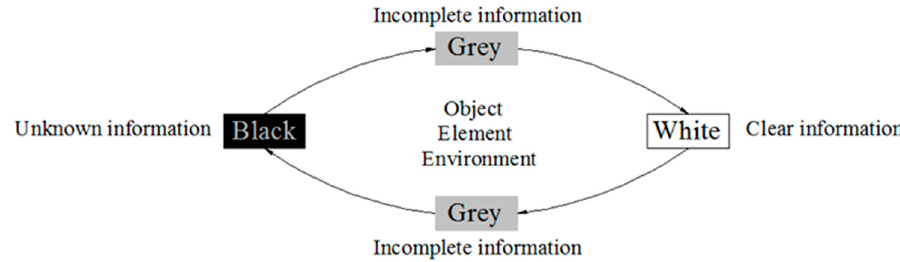
Figure 3. Concept map of the grey system.